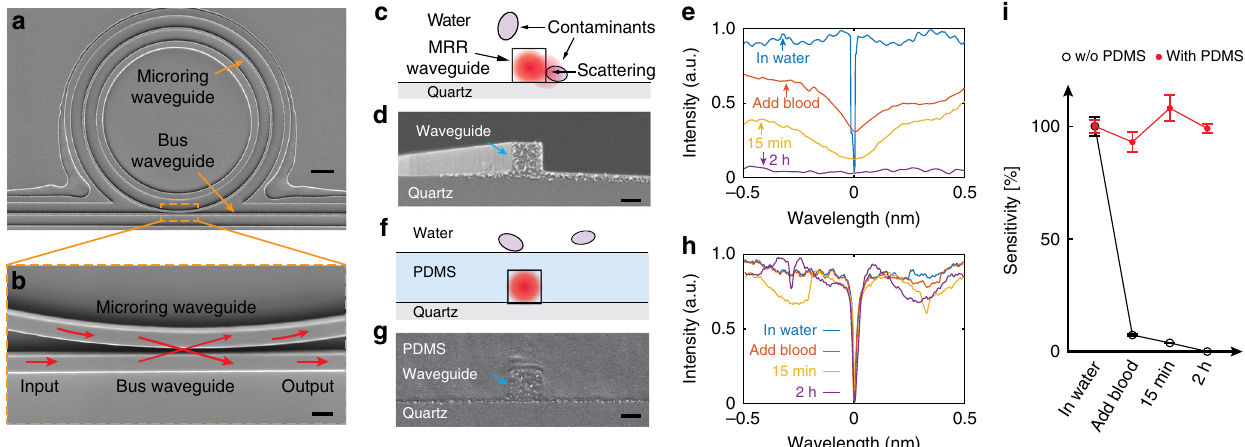
Fig. 3 Protecting MRR ultrasonic detector for long-term in vivo imaging. a Scanning electron microscope (SEM) image of a MRR ultrasonic detector fabricated by sNIL. Scale bar: 10 μ m; ( b ) Magni fi ed view of the waveguide coupling region highlighted by the orange dashed box in a . Scale bar: 500 nm. c Schematic and ( d ) SEM image of a cross-section of the fabricated MRR. The schematic illustrates potential contaminants attached to the waveguide. Scale bar: 500 nm. e Optical resonance diminished in 2 h due to contamination when unprotected MRR is exposed to whole blood. f Schematic and ( g ) SEM image of a cross-section of the MRR protected by an additional PDMS layer. Scale bar: 500 nm. The schematic illustrates that contamination to the waveguide is prevented. h Optical resonance remained unaffected after the protected MRR is exposed to whole blood for 2 h. i Comparison of Q-factors of MRRs with and without the protection layer in whole blood. Error bars show the standard deviation of Q-factor when fi tting with the